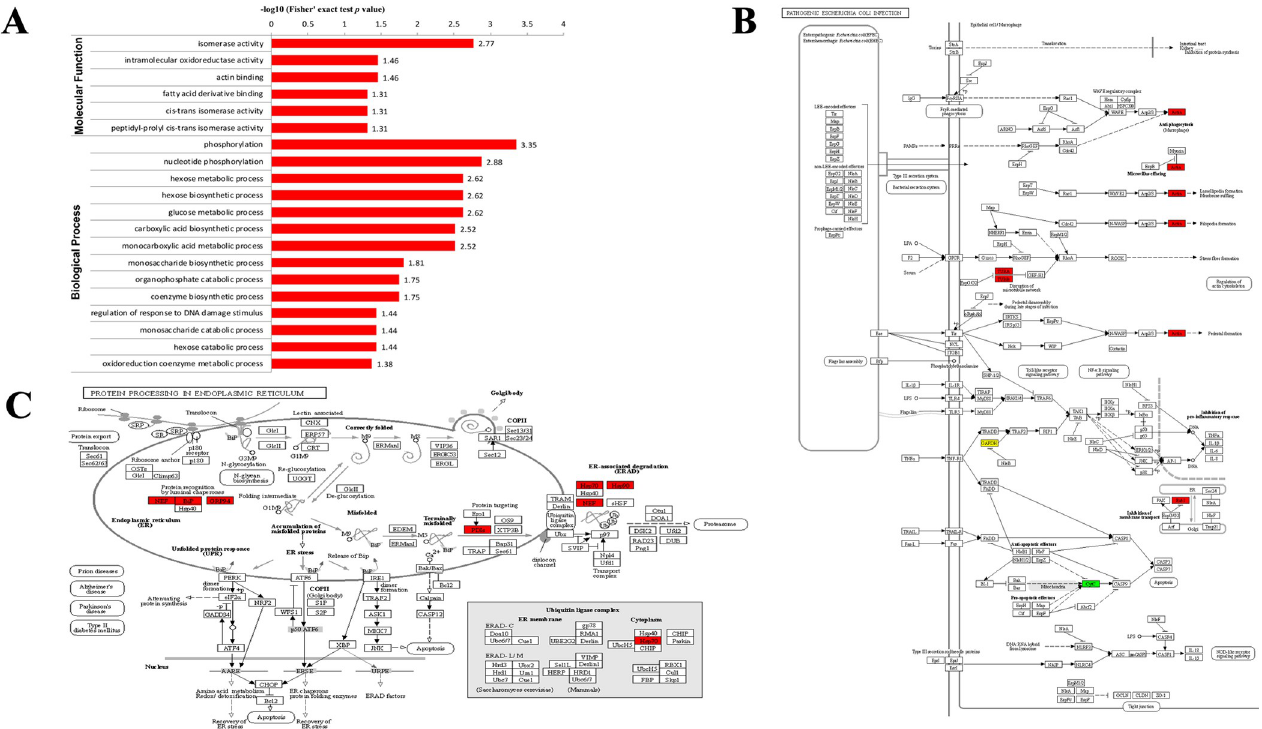
Fig 4. Functional enrichment analysis of differentially malonylated proteins in RH vs. PRU strains. (A) Advanced GO enrichment of the differentially malonylated proteins. (B) Alterations in the pathogenic Escherichia coli infection pathway with significantly enriched modified proteins showing inside red boxes. (C) Alterations in protein processing in endoplasmic reticulum pathway with significantly enriched modified proteins showing inside red boxes.